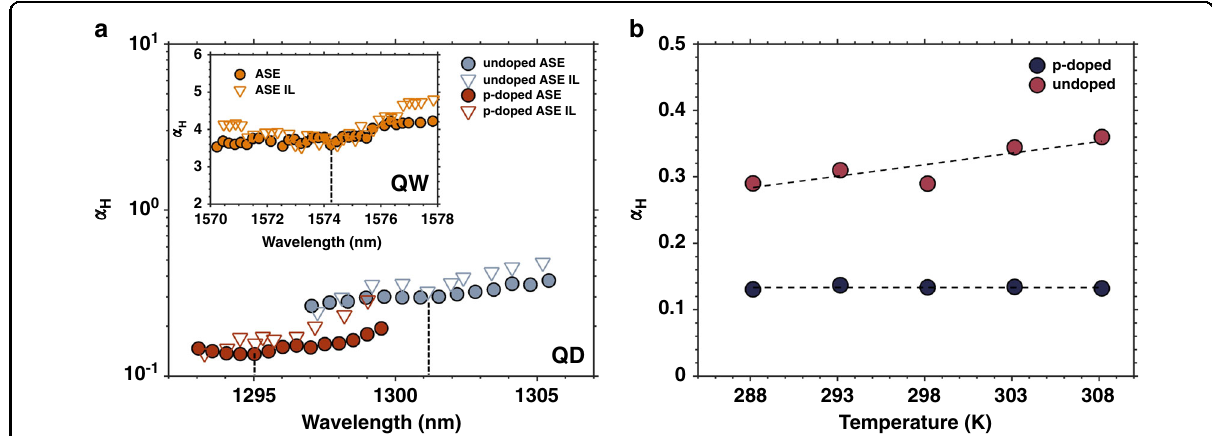
Fig. 7 Linewidth enhancement factor ( α H) measured by ASE and ASE-IL methods. ( a ) The α H spectral dependence for undoped and p-doped QD lasers. The vertical dotted lines indicate gain peak α H values. The inset displays the measured α H values for the QW laser α H s. ( b ) The α H at gain peak versus temperature for undoped and p-doped QD lasers. The linear curve- fi ttings (dotted lines) are only for guiding